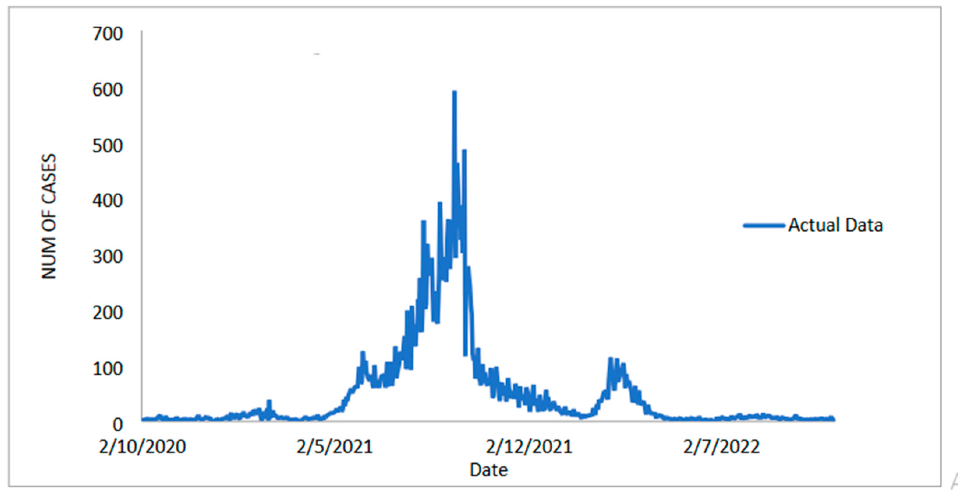
Figure 6. Malaysian daily new deaths COVID-19 cases (1 October 2020 to 4 November 2022).